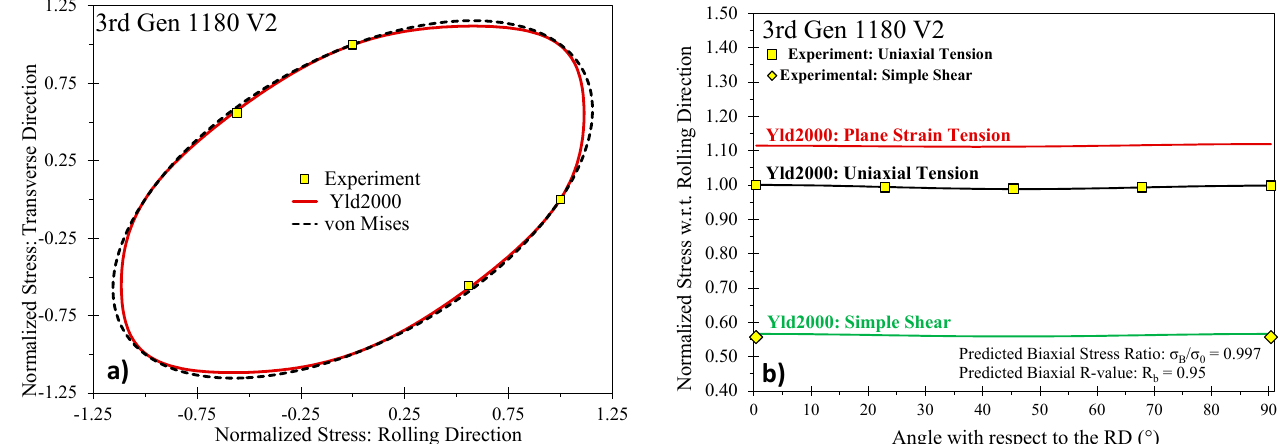
Figure 8. Calibrated Barlat Yld2000 yield surface for the DP980 ( a ) and predicted stress ratios ( b ).